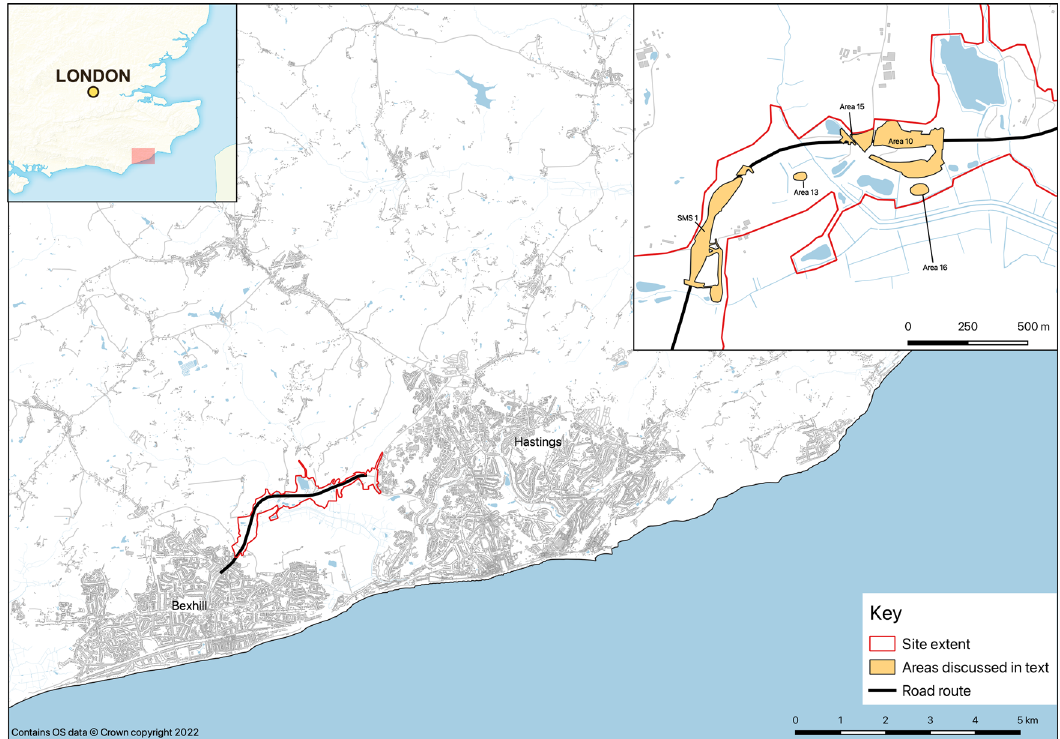
Figure 2: Location map of